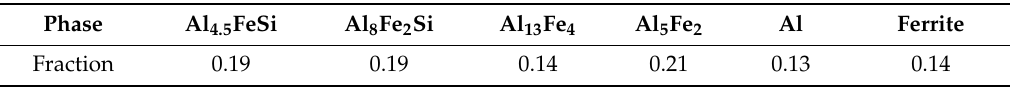
Figure 9. EBSD phase distribution map of compounds formed at the cast iron / liquid Al–Si alloy interface isothermally heated at 720 °C for 10 min. Table 4. Phase fraction (number) of the compound region at the interface of cast iron / liquid Al–Si alloy shown in Figure